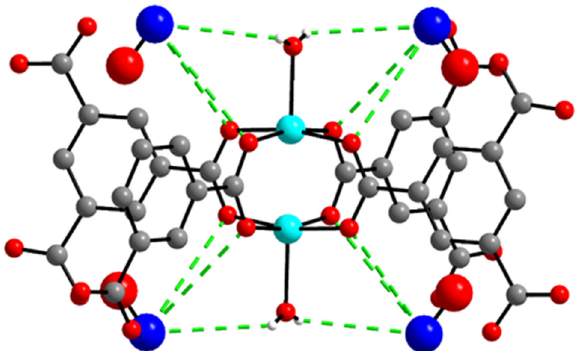
Figure 1. ( a ) Structure of Cu-BTC, Fm-3m , a = b = c = 26.3015(4) Å, V = 18194.6(5) Å 3 . ( b ) Structure of NO ⊂ micro-Cu-BTC, Fm-3m , a = b = c = 26.3068(11) Å, V = 18205.6(5) Å 3 . NO molecules are shown in space filled models. The color codes: green, Cu; grey, carbon; red, oxygen; blue, nitrogen.